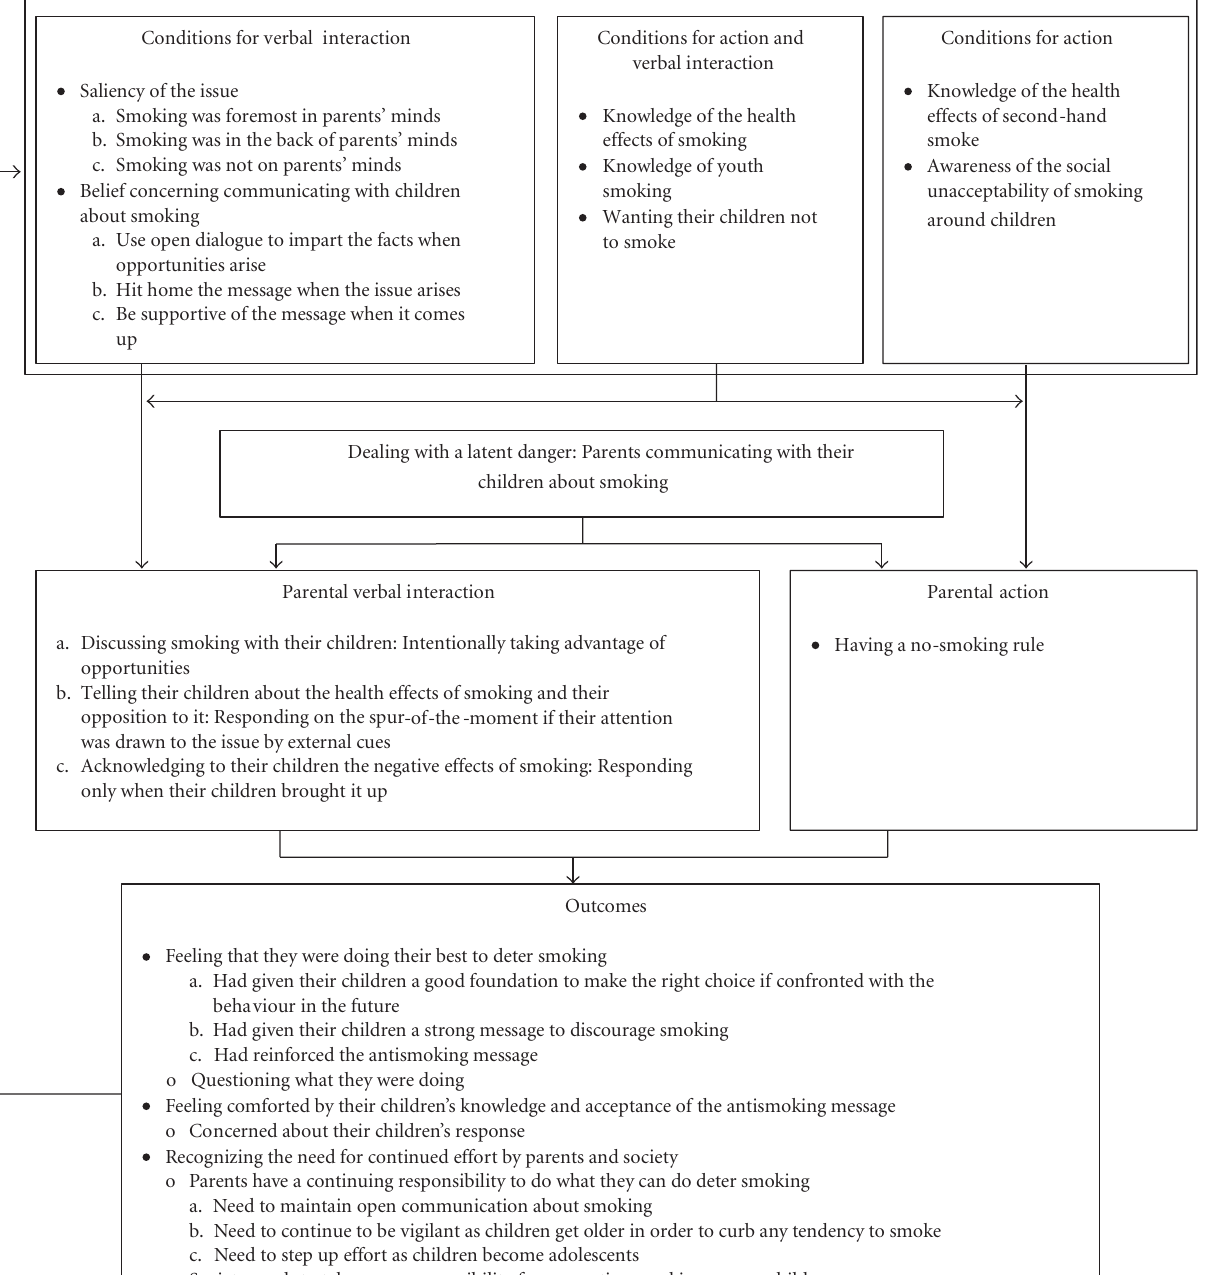
Figure 1: A theoretical model of the process that parents used in communicating with their children about smoking. Verbal interaction and action were influenced by conditions and resulted in outcomes for the parents. The outcomes fed back and contributed to the context for the parents’ continuing action and interaction to deal with the latent danger. Note. The letters for conditions and outcomes correspond with the respective letters for the verbal interaction approaches and indicate variation according to the particular interaction